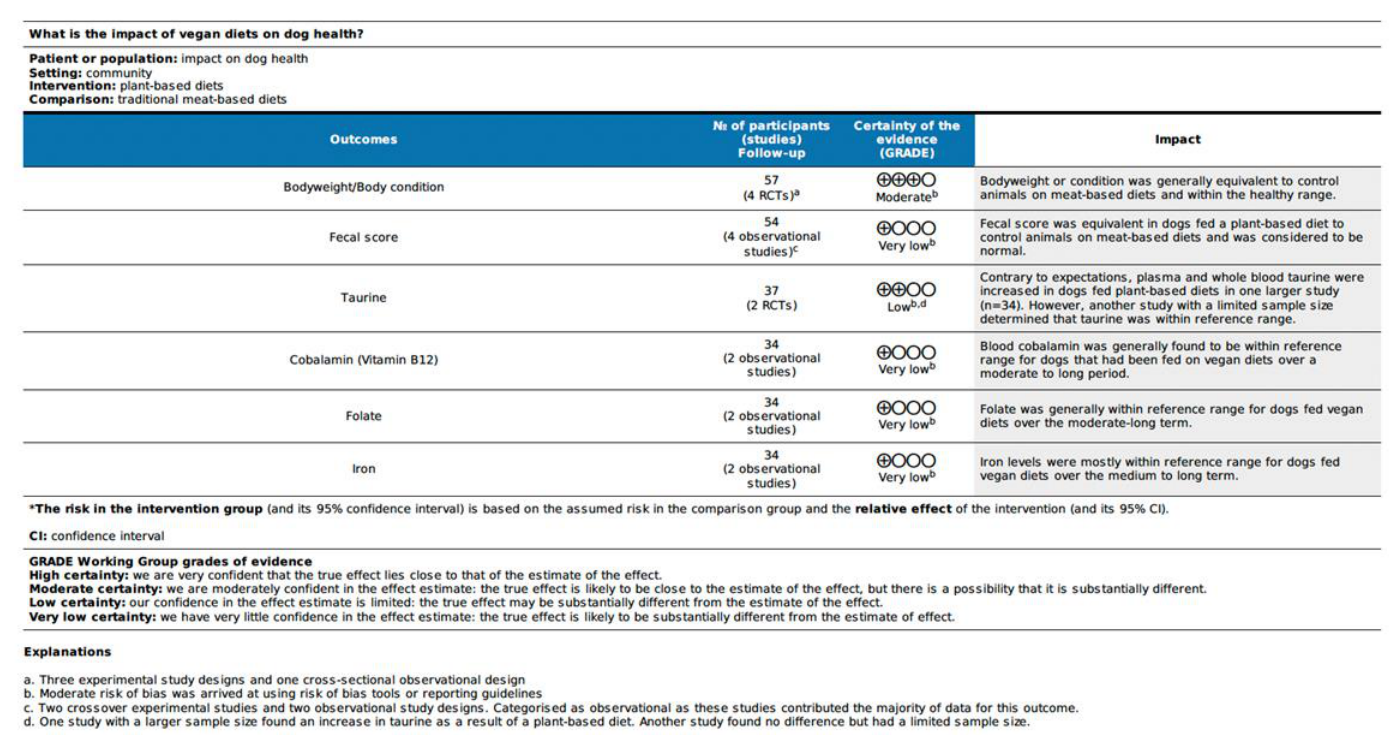
Figure 10. GRADE Summary of Findings table for animal—based outcomes of health assessed in dogs fed a vegan diet.